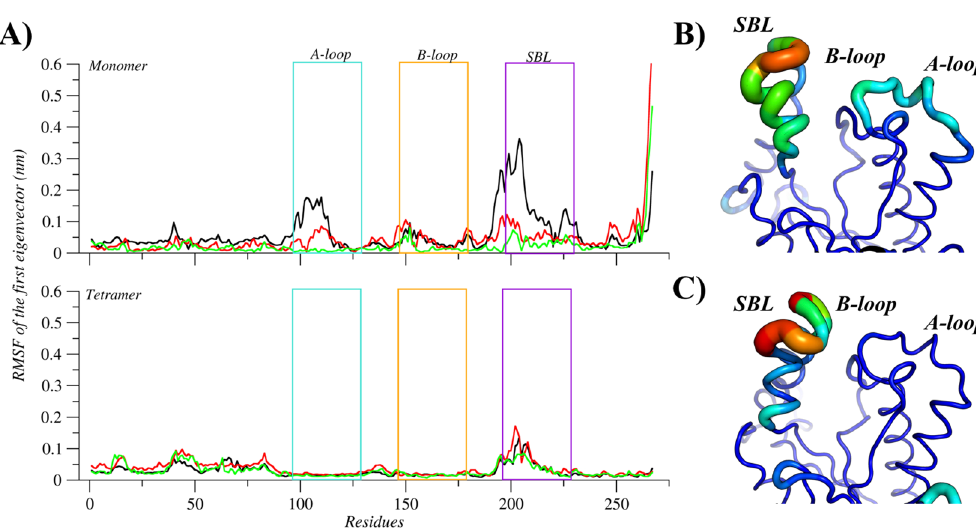
Figure 6. Flexibility of the MtInhA associated with NADH and substrate analogue (THT). ( A ) Root mean of the root mean square fluctuation (RMSF) for the monomeric and tetrameric systems, according to the first eigenvector. The regions A-loop, B-loo, and SBL are highlighted with boxes and coloured in light blue, orange, and purple, respectively. In addition, black, red and green lines represent the three simulations’ repetitions. The mobility and conformation change of the most representative structure extracted from the MD trajectories for monomer ( B ) and tetramer ( C ). The thickness is proportional to B-factor values. Image generated with XMGrace 38 and PyMOL 36